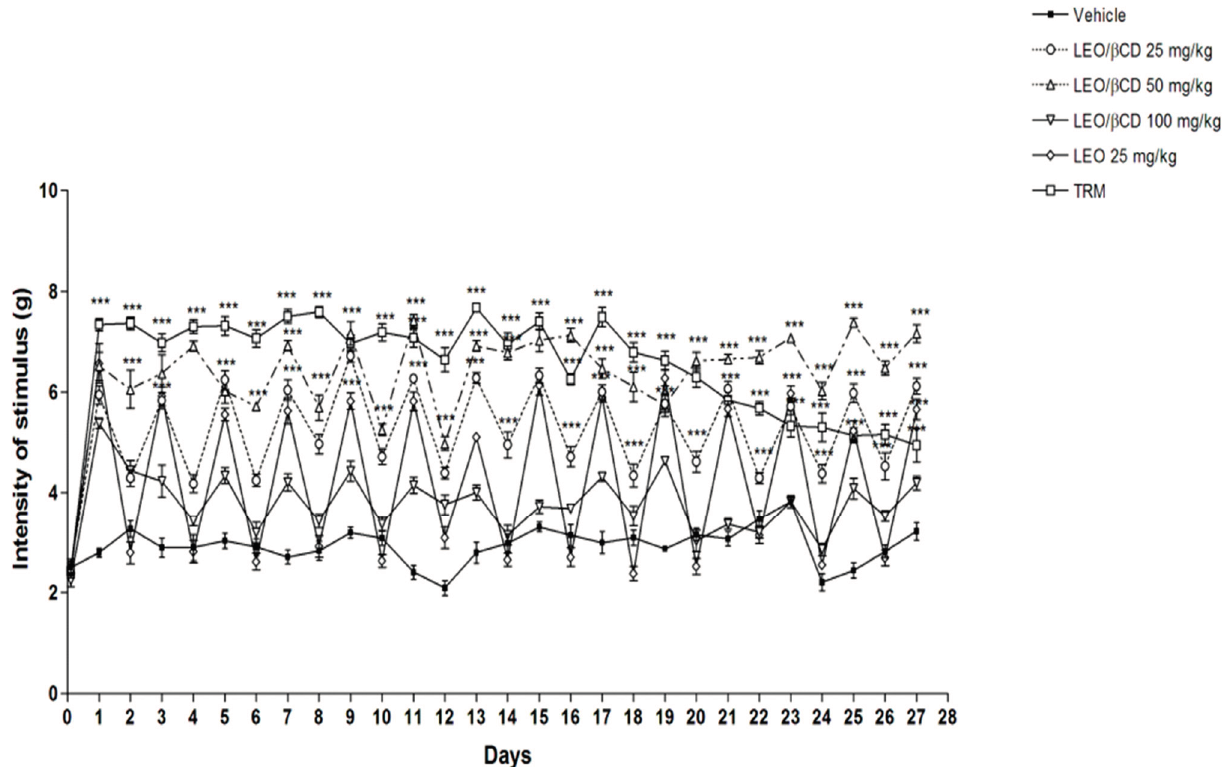
Figure 3. Effect of chronic administration of vehicle, O. basilicum essential oil (LEO; 25 mg/kg, p.o.), O. basilicum essential oil and β -Cyclodextrin (LEO- β CD; 25, 50 and 100 mg/kg, p.o.) or tramadol (TRM, 4 mg/kg) on mechanical hyperalgesia induced by acid saline. Each point represents the mean ± SEM of the paw withdrawal threshold (in grams) to tactile stimulation of the ipsilateral hind paw. *** p < 0.001 vs. control group (ANOVA followed by Bonferroni